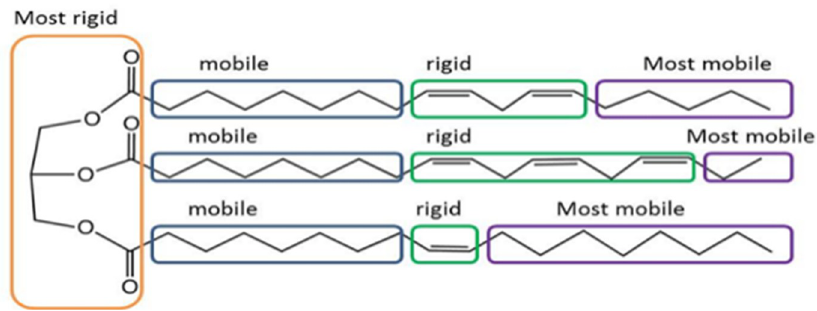
Figure 5. PUFA‐rich TAG structure and segmental rigidity mobility [27].